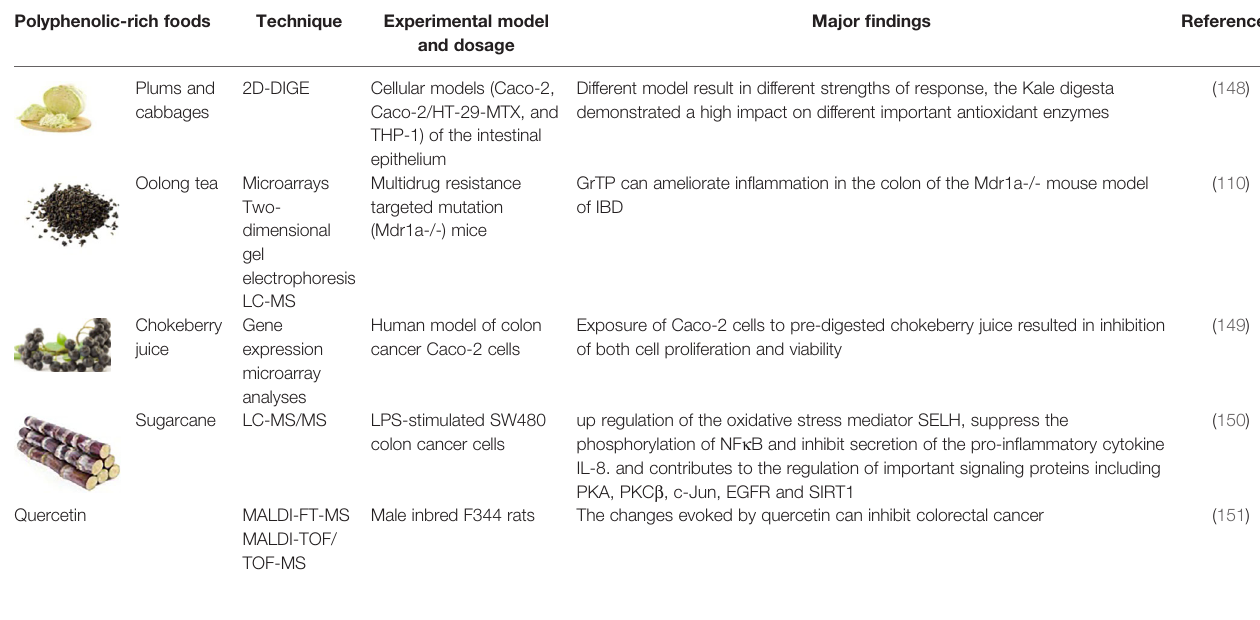
TABLE 2-2 | Transcriptomics and Proteomics in understanding the GI protective effects by polyphenols and polyphenolic-rich foods. Polyphenolic-rich